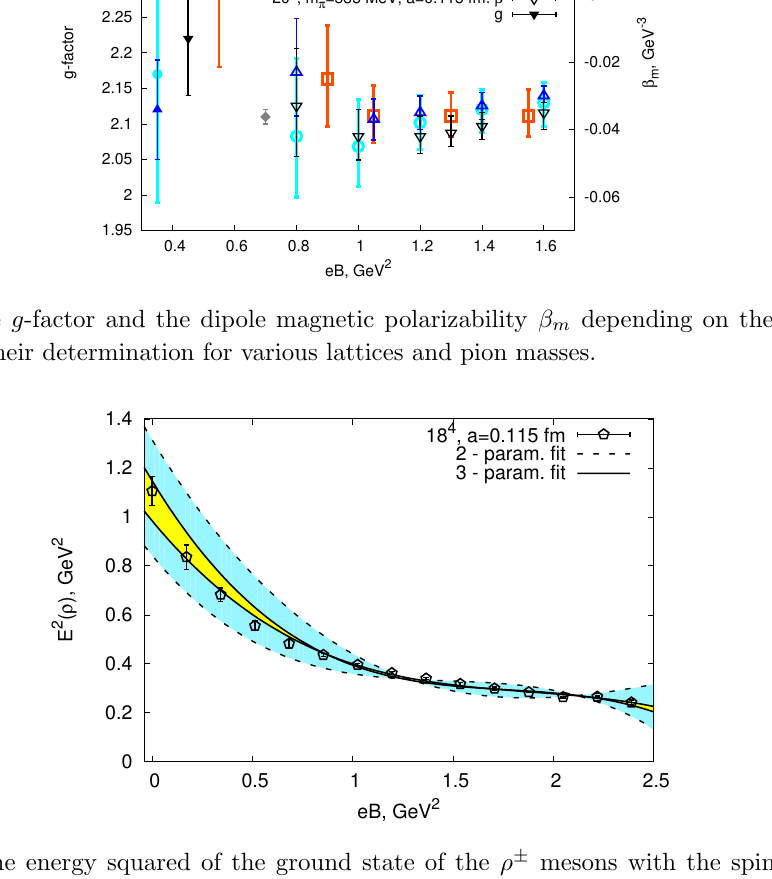
Table 4. The magnetic dipole polarizabilty (cid:12) m , the magnetic hyperpolarizability (cid:12) 1 h (cid:26) meson obtained from the 3-parametric (cid:12)t (4.2), where we use the data presented in table 1. The results are obtained for various lattice volumes V , lattice spacings a and pion masses m (cid:25) , (cid:31) 2 =d:o:f . values correspond to the (cid:12)t at the average g -factor value.